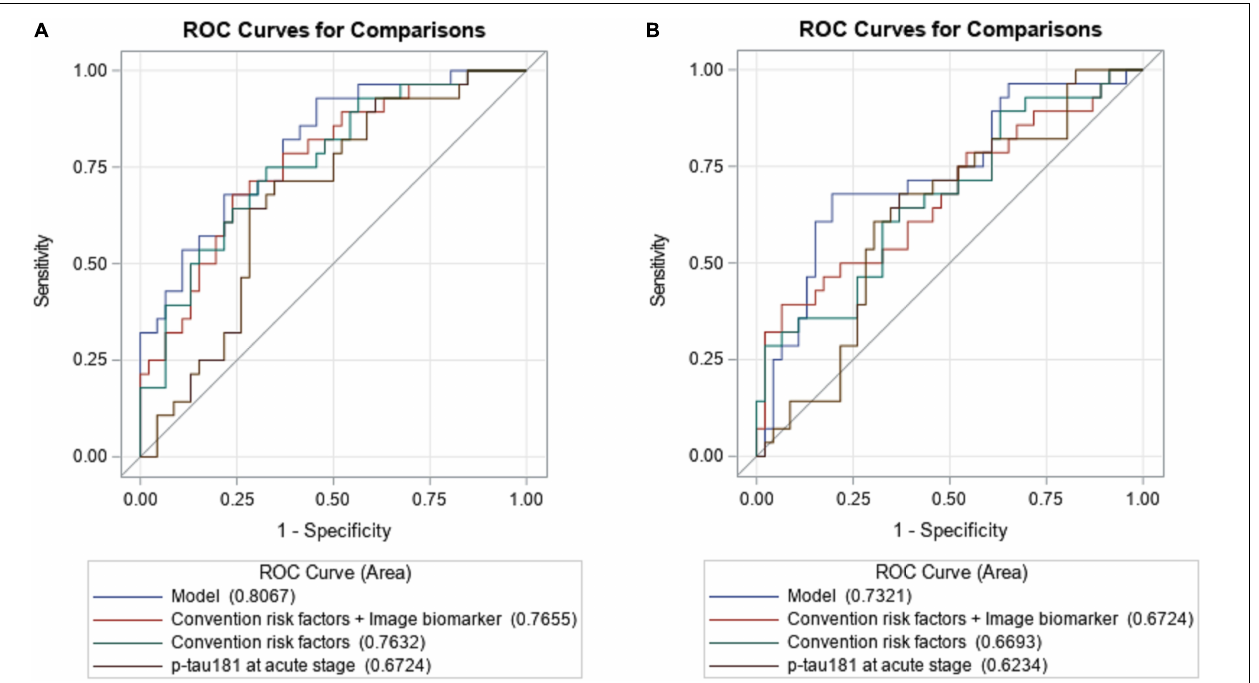
Frontiers in Aging Neuroscience |